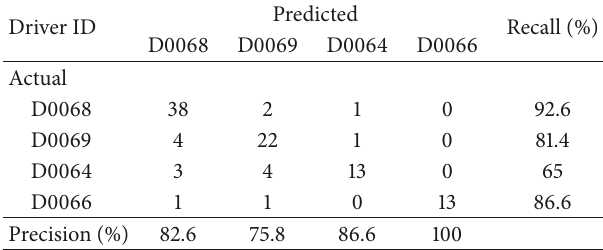
Table 5: Accuracy and confusion matrix on group 6 (G6) of drivers with all features.